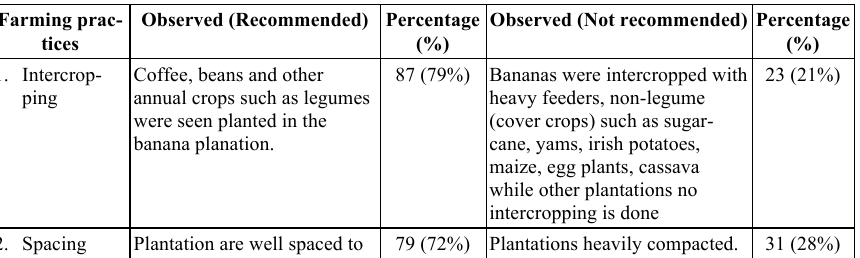
Table 2. Recommended and not recommended banana farming practices observed during end line